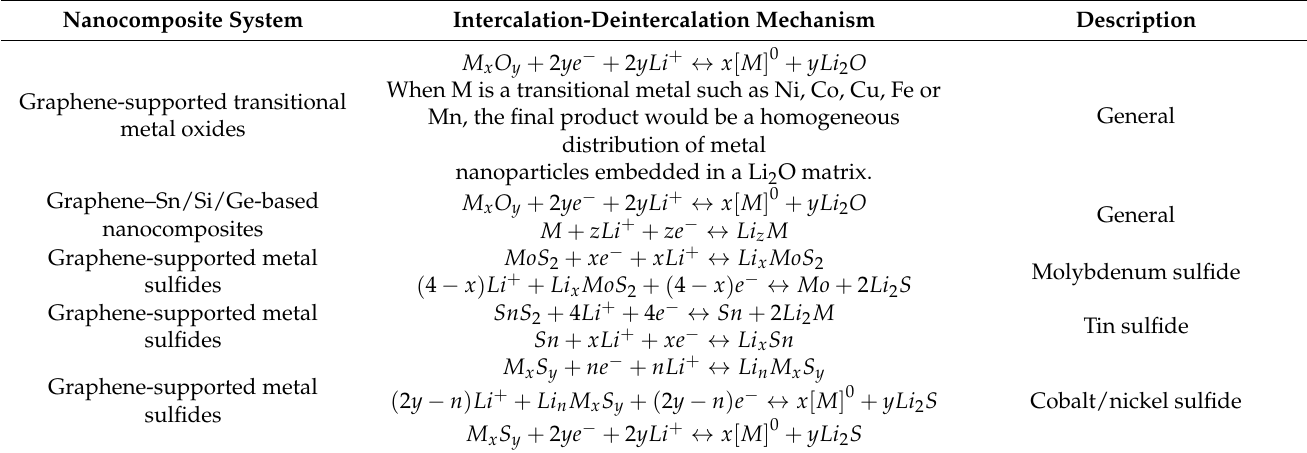
Table 3. Electrochemical mechanism of intercalation of various graphene-based nanocomposites for LIBs, based on [42]. Nanocomposite System